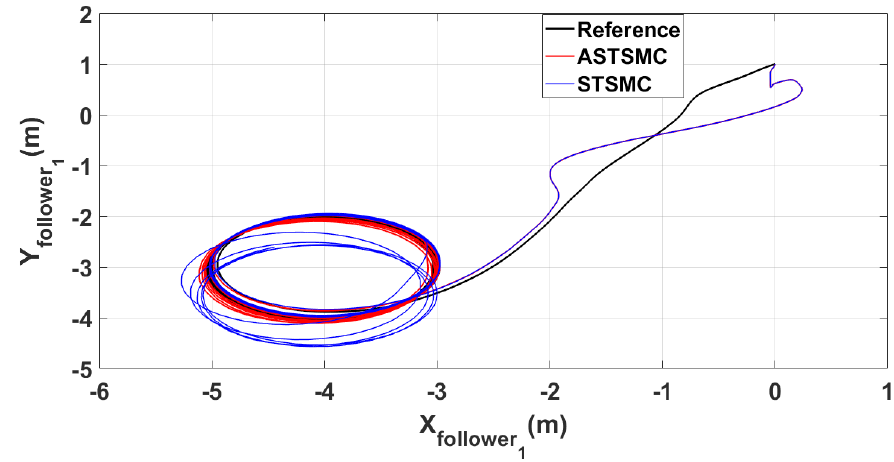
Figure 6. XY follower1 trajectory tracking comparison under wind disturbance.